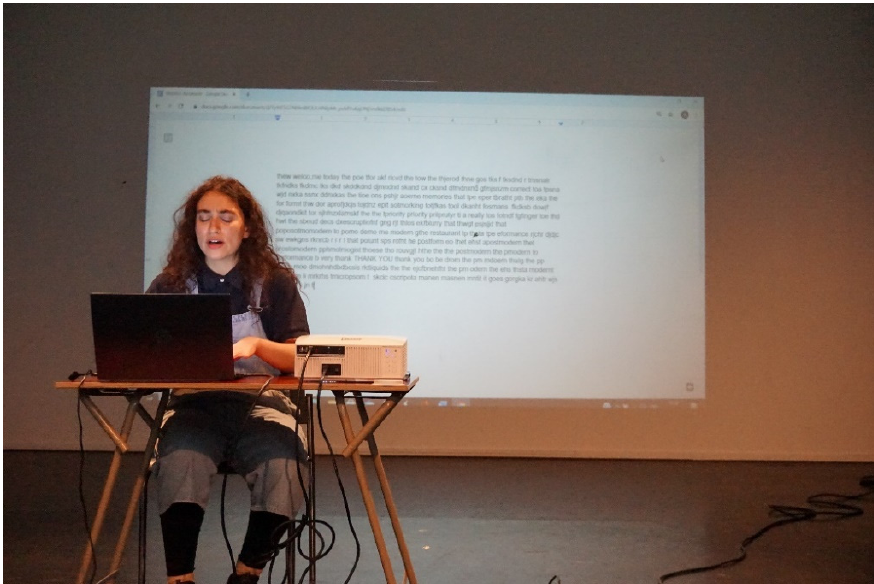
Figure 1. One of my first performances of nonstop languaging at HOME OF PERFORMANCE PRACTICES, in early 2021. In this experiment I simultaneously talked and wrote nonstop, projecting the live writing behind me. I invited the audience to witness the performance for 20’, followed by a feedback session. Photo: Ella Tighe, ArtEZ University of the Arts, Arnhem, 2021.